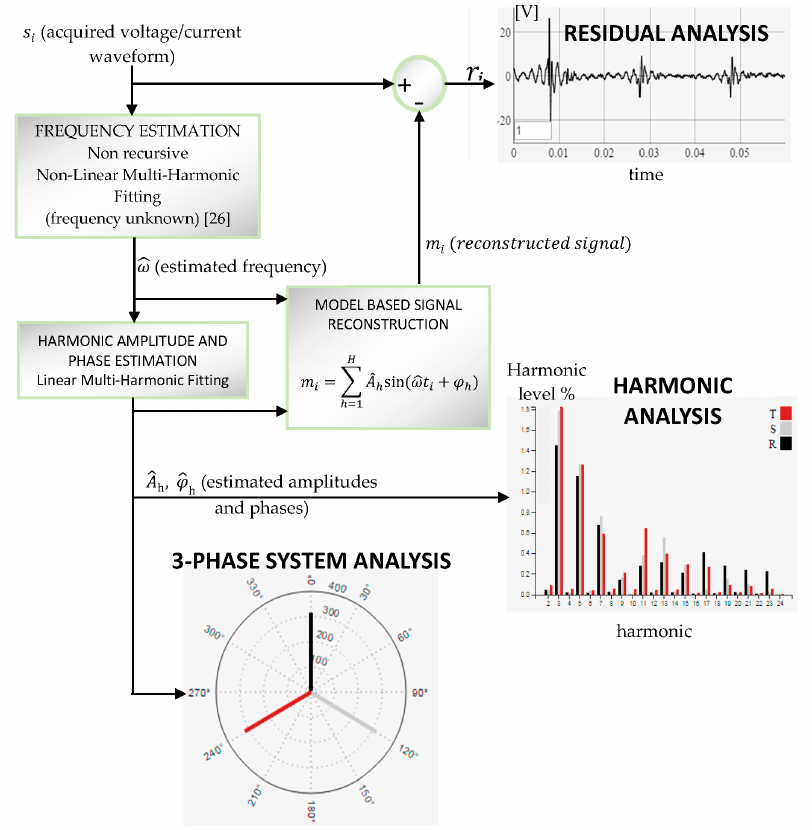
Figure 7. Calculus scheme of the implemented signal processing.